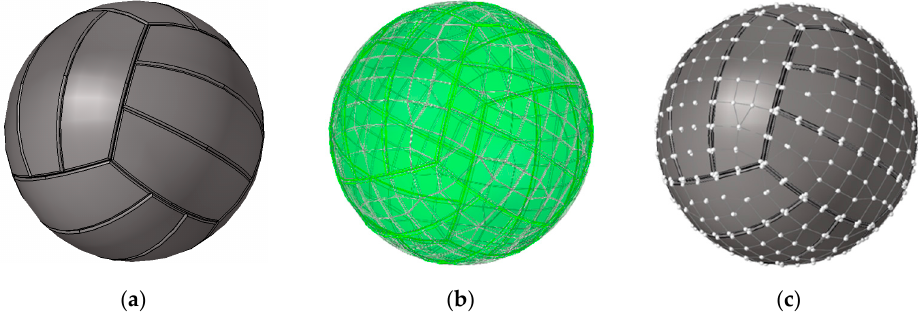
Figure 9. Sampling point acquisition for basketball model: ( a ) CAD model; ( b ) grid division; ( c ) sampling data points.